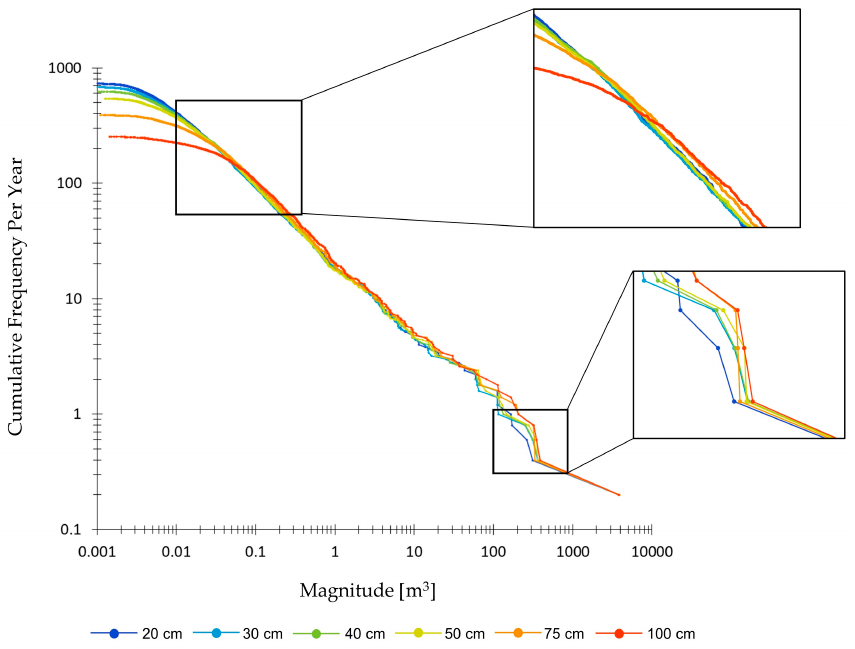
Figure 12. Cumulative frequency-magnitude curves for all six inventories. The larger projection diameters cause a downward shift in the beginning of the curve. The linear portion of each curve are similar, but diverge at magnitudes greater than 5 m 3 .